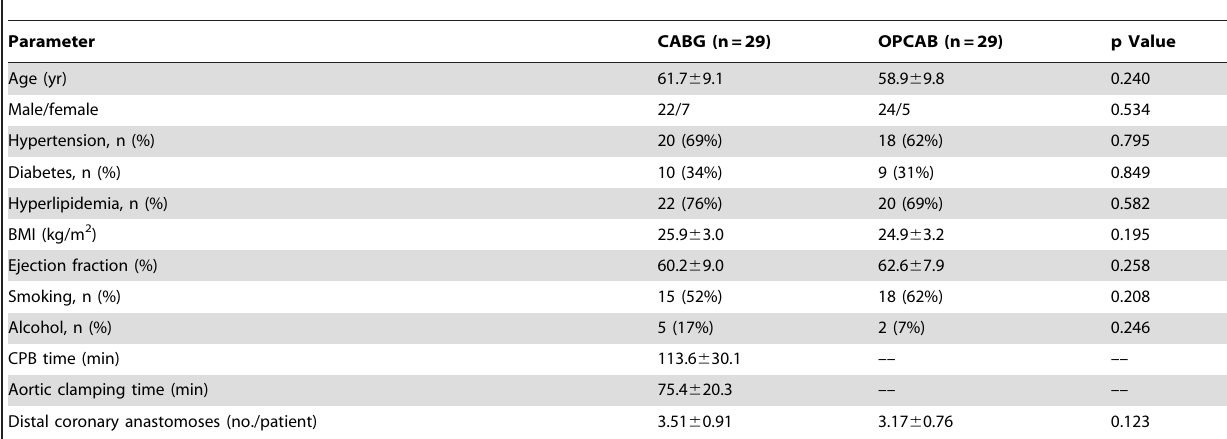
Table 1. Perioperative patient characteristics and clinical data.